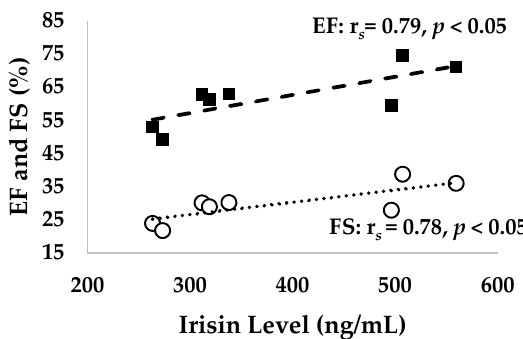
Figure 2. The correlation between the irisin levels and ejection fraction (%) as well as fractional shortening (%).